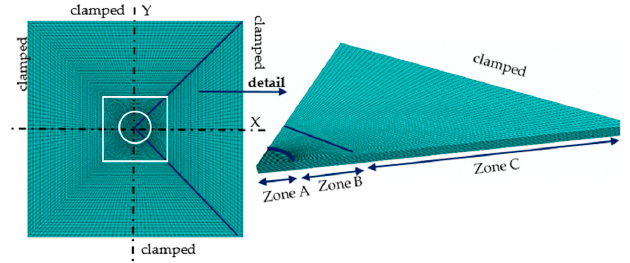
Figure 7. Specimen mesh. Figure 7. Specimen